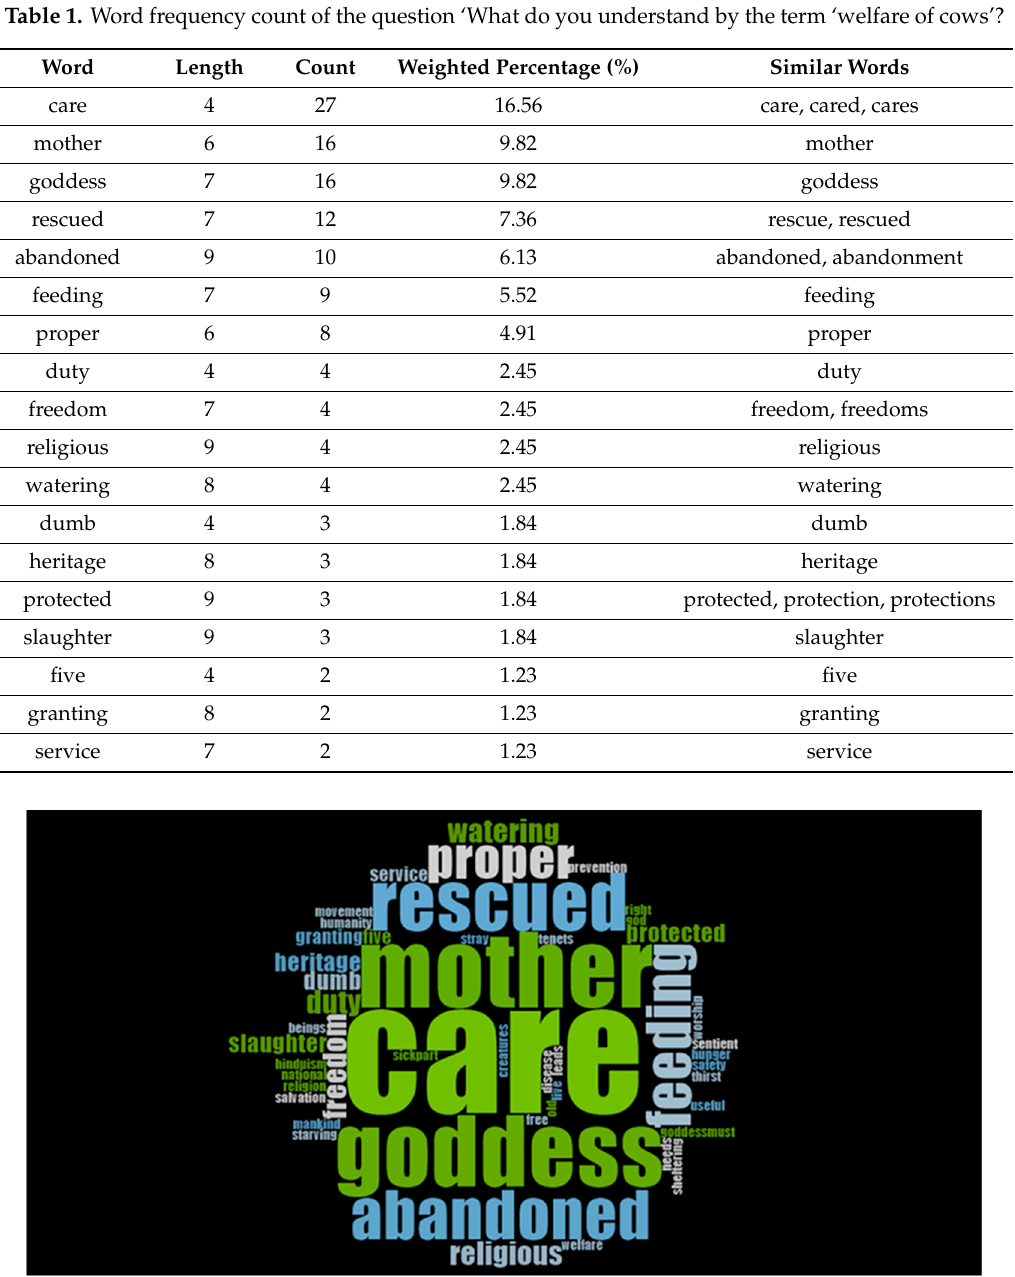
Figure 3. Word Cloud for the question ‘What do you understand by the term ‘welfare of cows’?